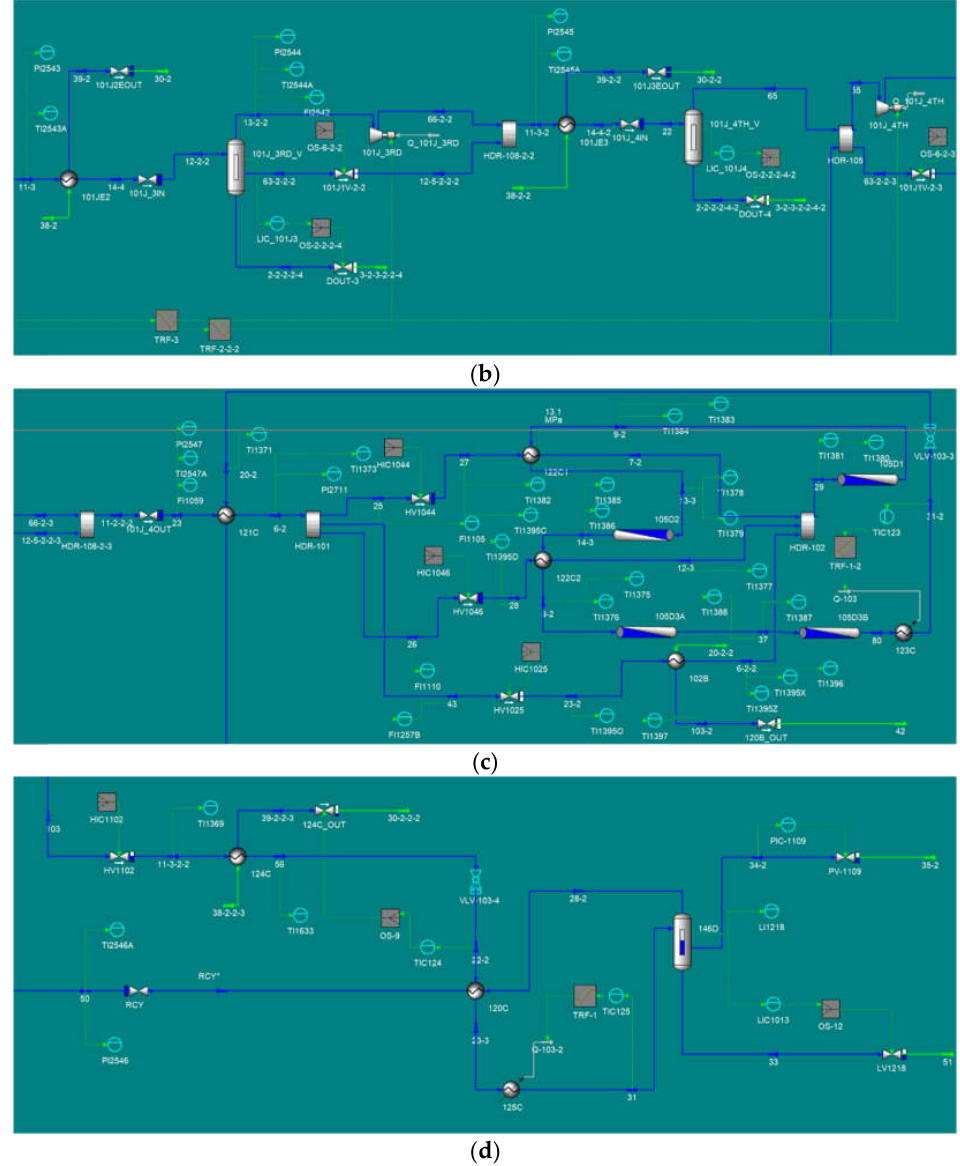
Figure 3. UniSim model of the green ammonia process: ( a ) syngas buffer section-1; ( b ) syngas buffer section-2; ( c ) reaction section; and ( d ) product refining section. The recycle logistics in ( d ) are connected to ( b ).